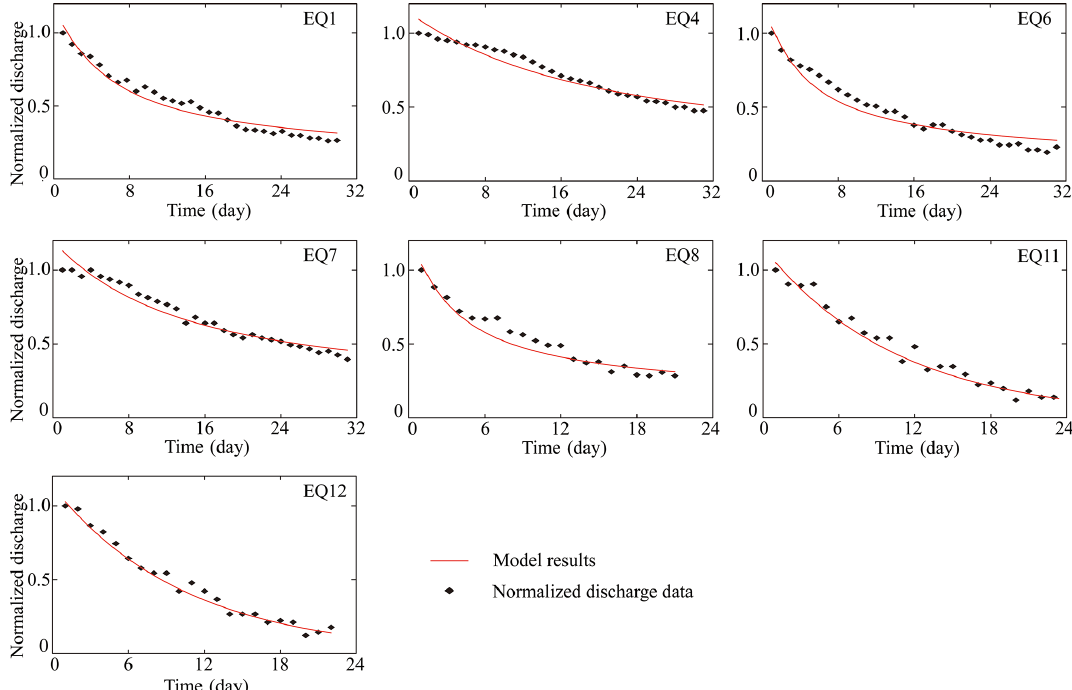
Figure 7. Model results compared with normalized discharge data for the discharge coseismic response in DZ